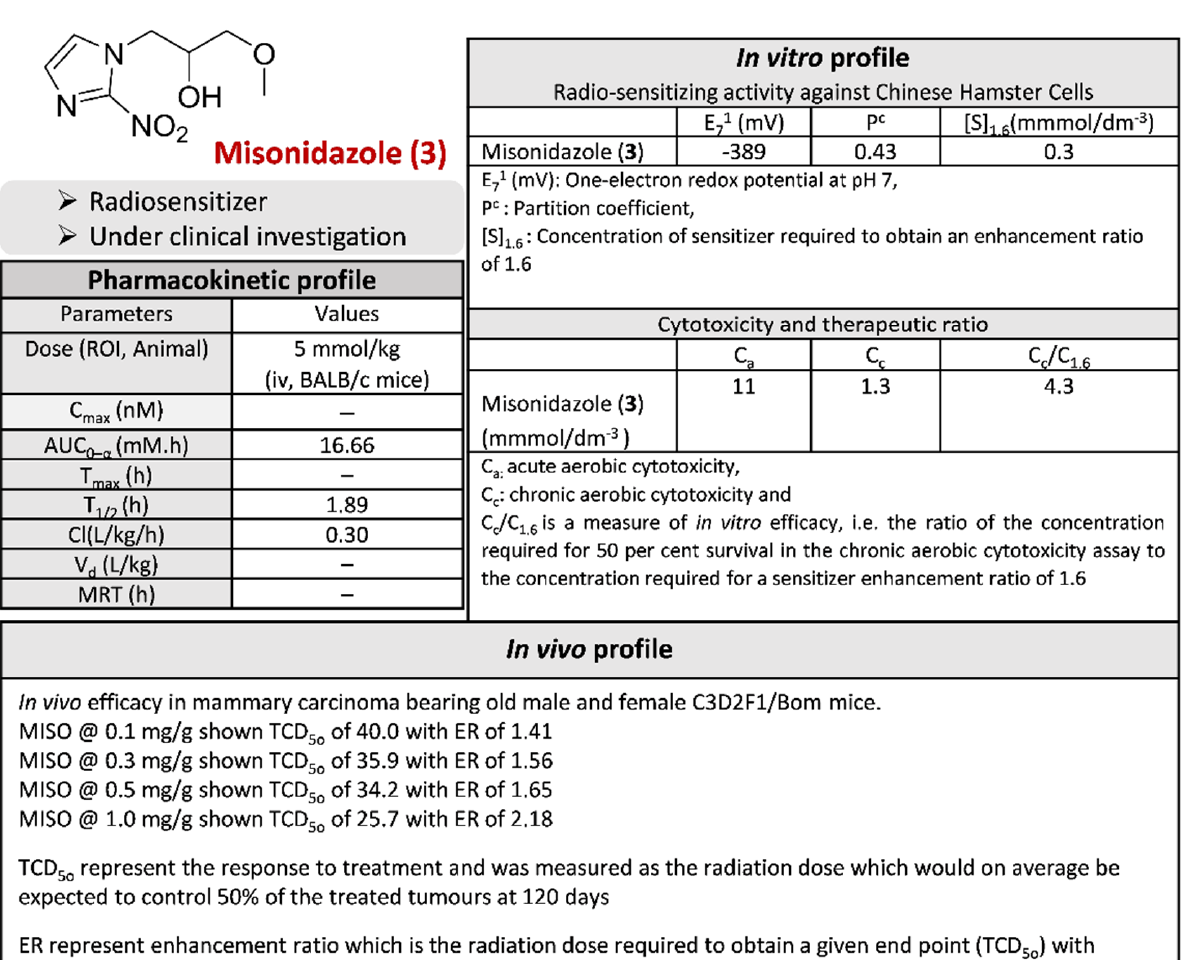
Figure 6. Activity profile of Misonidazole 3 [57–59].